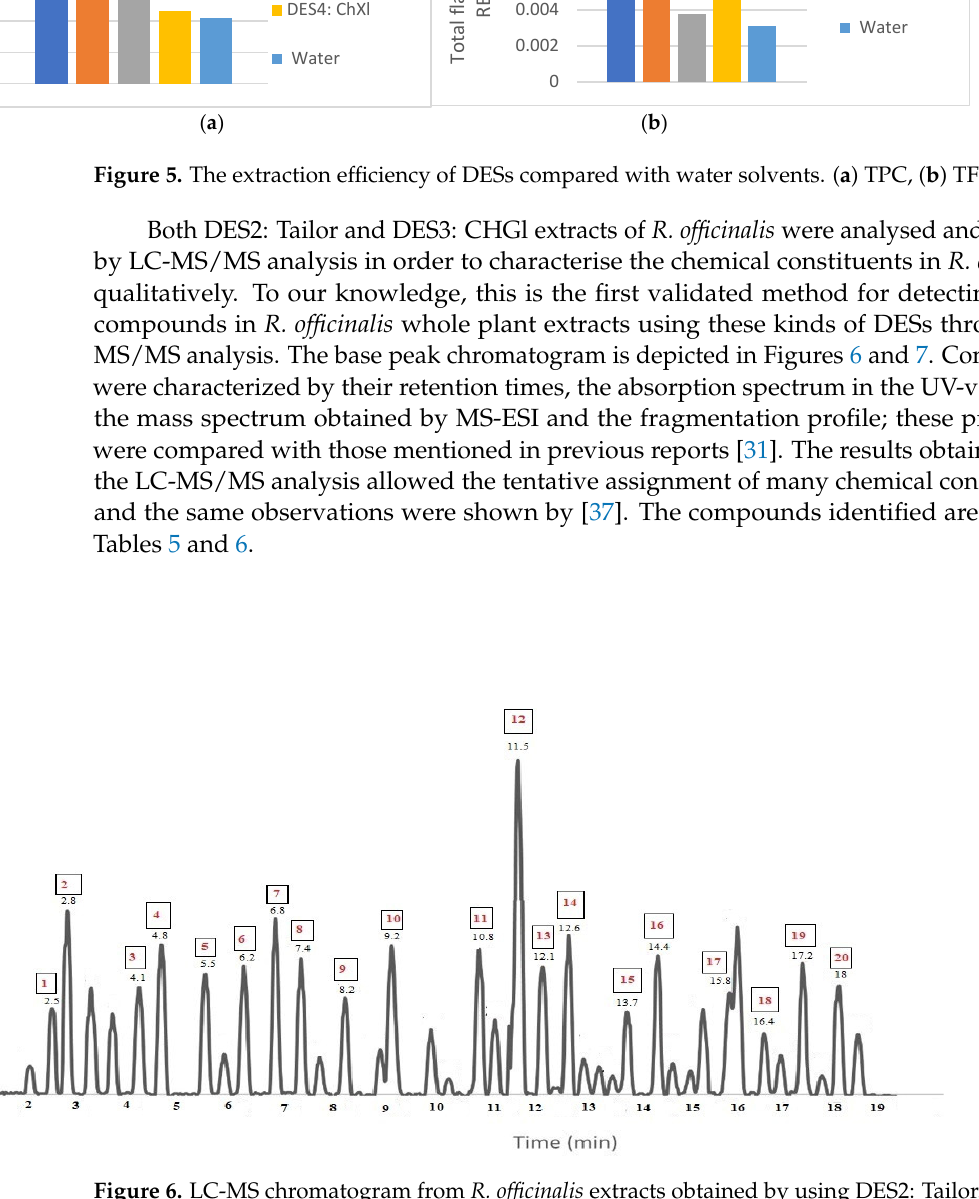
Figure 6. LC-MS chromatogram from R. officinalis extracts obtained by using DES2: Tailor.